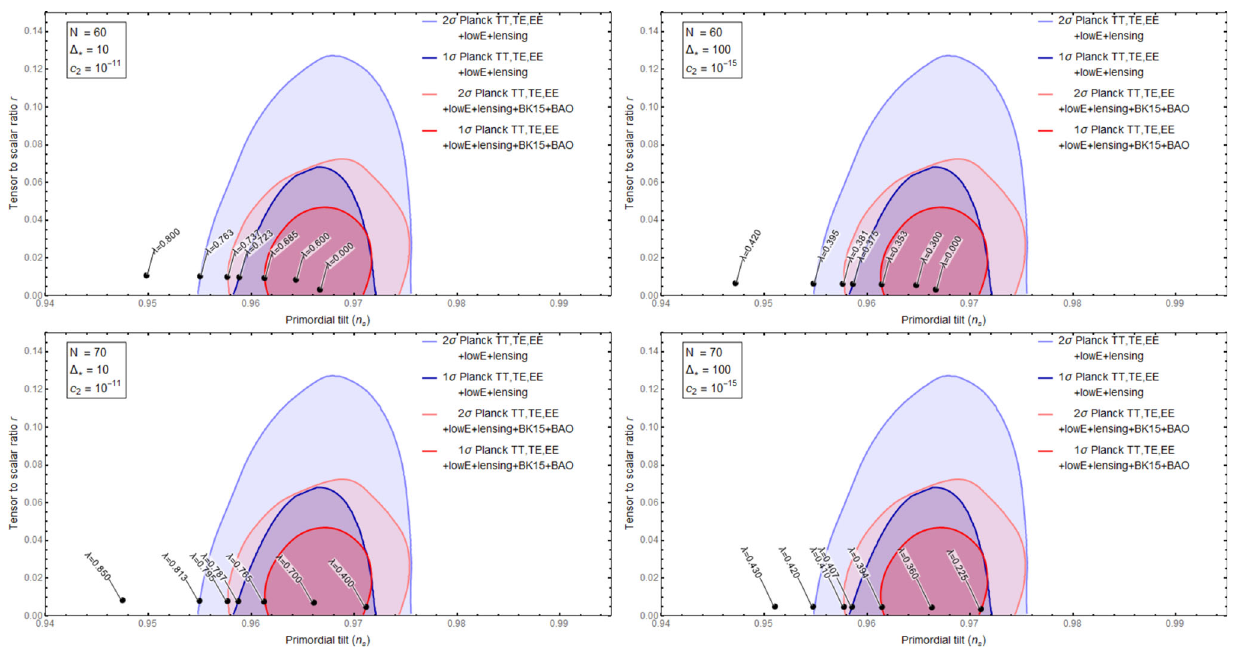
= 10 − 11 , N = 70 (lower-left panel) and (cid:23) (cid:25) = 100 , c (cid:23) (cid:25) = 10 , c 2 10 − 15 , N = 70 (lower-right panel) with Planck’18 results for TT, TE, EE, +lowE+lensing and +BK15+BAO